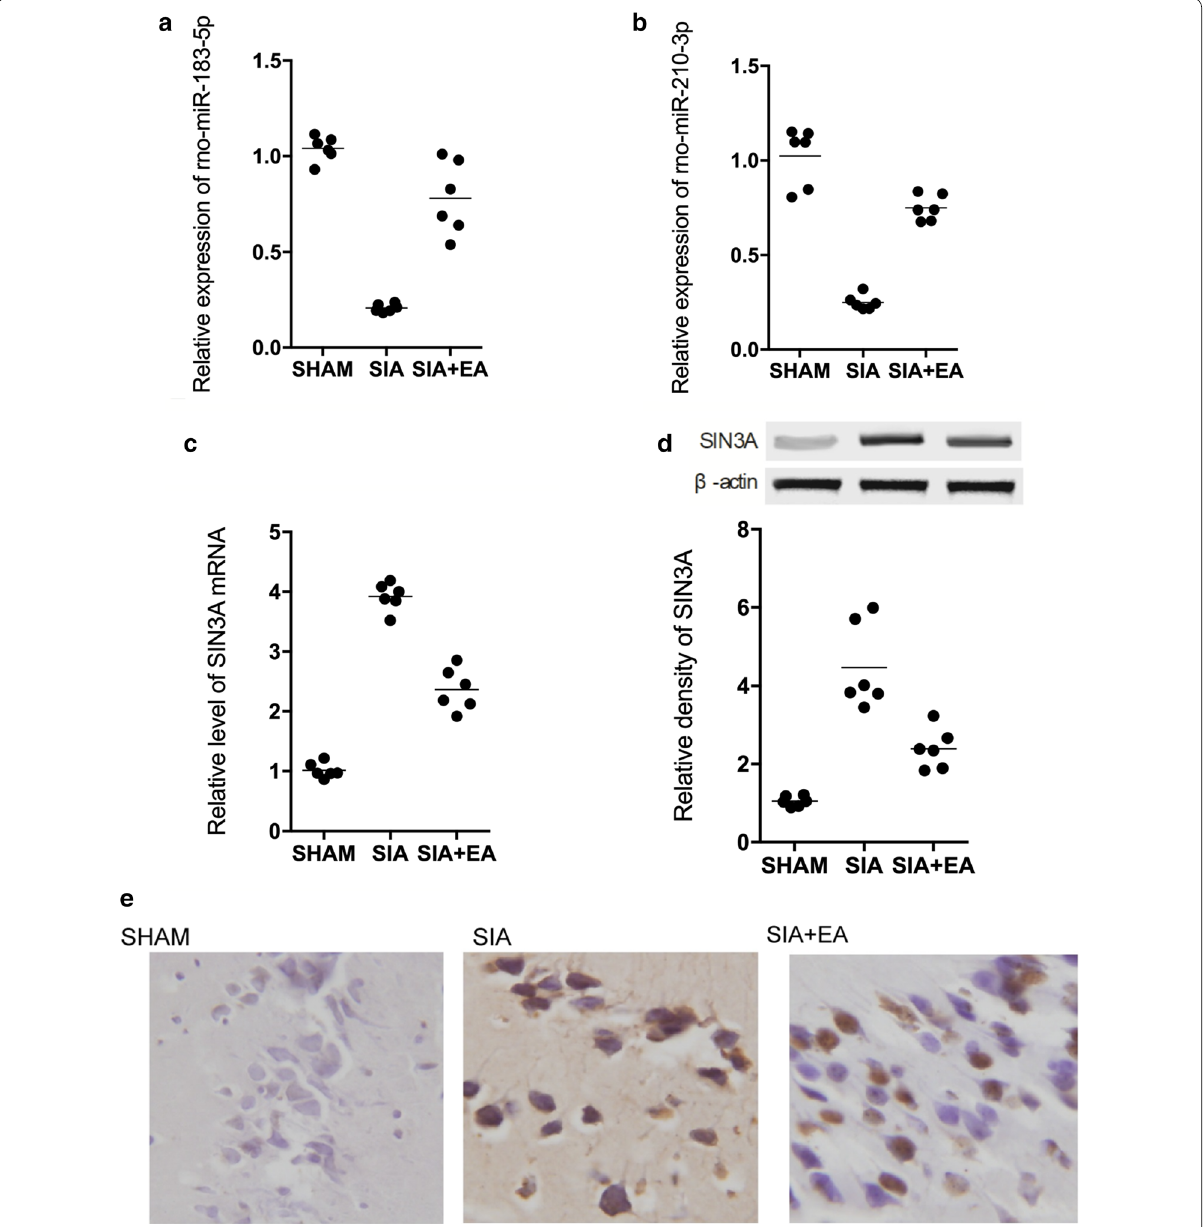
Fig. 4 EA treatment restored up-regulated rno-miR-183-5p and rno-miR-210-3p, and down-regulated SIN3A mRNA and protein in SIA rats ( a – c Real-time PCR; d Western blot; e IHC analysis; Technical repeats n 3; Animal number in each group N 6; *p value < 0.05, vs sham group; = = **p value < 0.05, vs. SIA group). a Rno-miR-183-5p expression was the lowest in SIA rats, while EA treatment partly restored the rno-miR-183-5p expression in SIA rats. b Rno-miR-210-3p expression was the lowest in SIA rats, while EA treatment partly restored the rno-miR-210-3p expression in SIA rats. c The level of SIN3A mRNA was the highest in SIA rats, while EA treatment partly restored the SIN3A mRNA expression in SIA rats. d The level of SIN3A protein was the highest in SIA rats, while EA treatment partly restored the SIN3A protein level in SIA rats. e EA treatment reduced SIN3A expression in the hippocampus of SIA